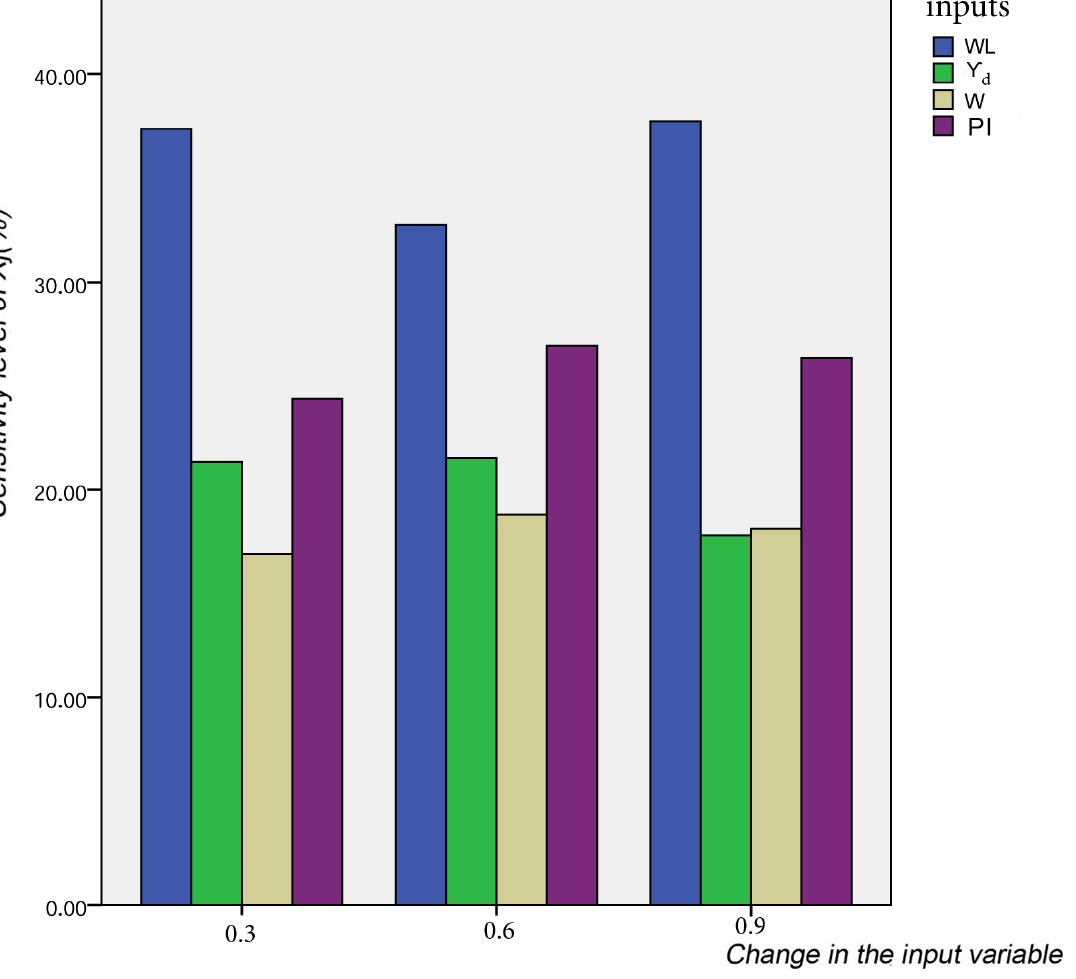
Figure 8. Results of the sensitivity analysis of the proposed model.